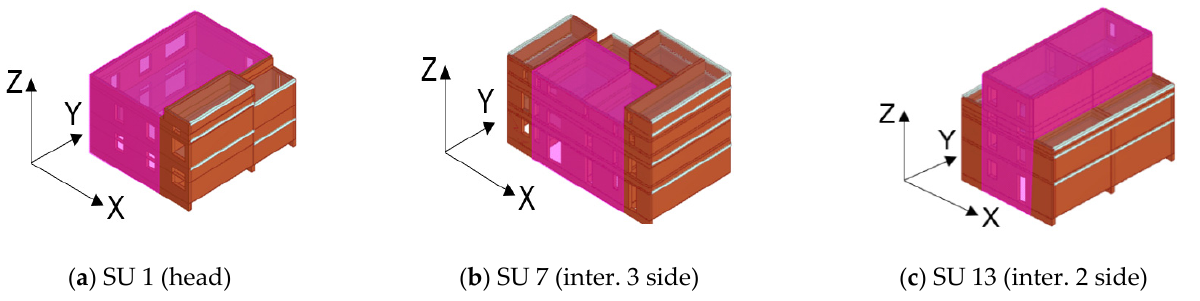
Figure 9. Numerical model of the reference case study SUs: ( a ) head SU, ( b ) intermediate SU confined on 3 sides, and ( c ) intermediate SU confined on 2 sides.